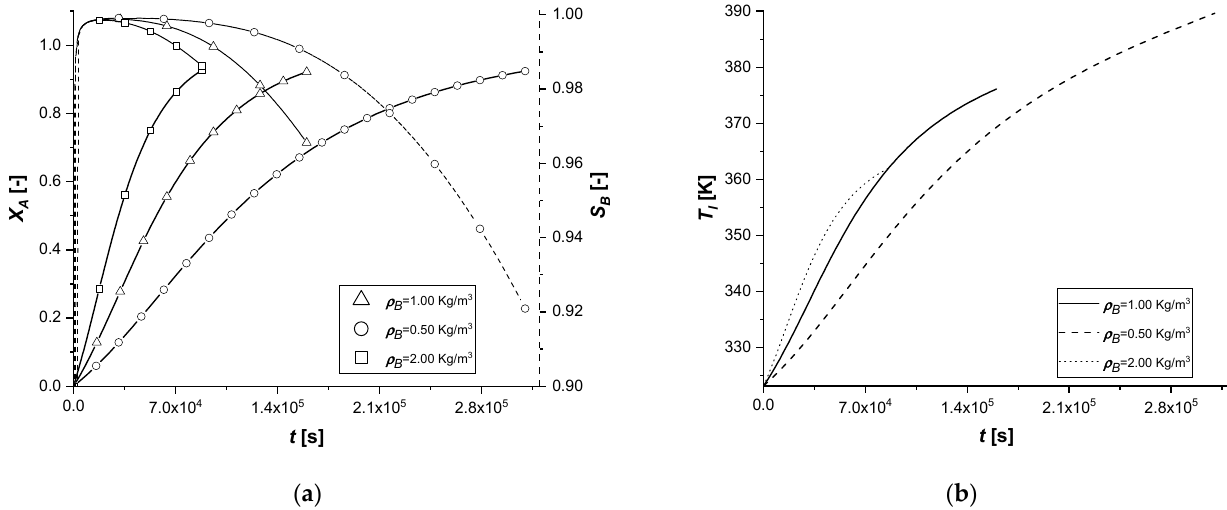
Figure 25. EY ρ P investigation. ( a ) Bulk profiles over time of X A and S B . ( b ) Bulk profile of T l over time.